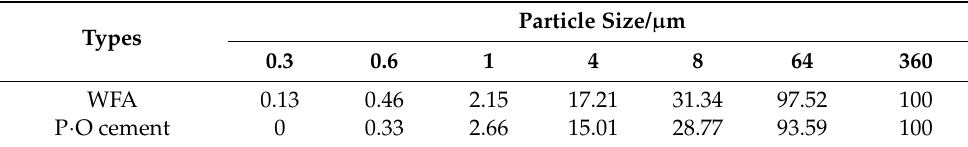
Table 2. Particle passing percentage of the cementitious materials/%.